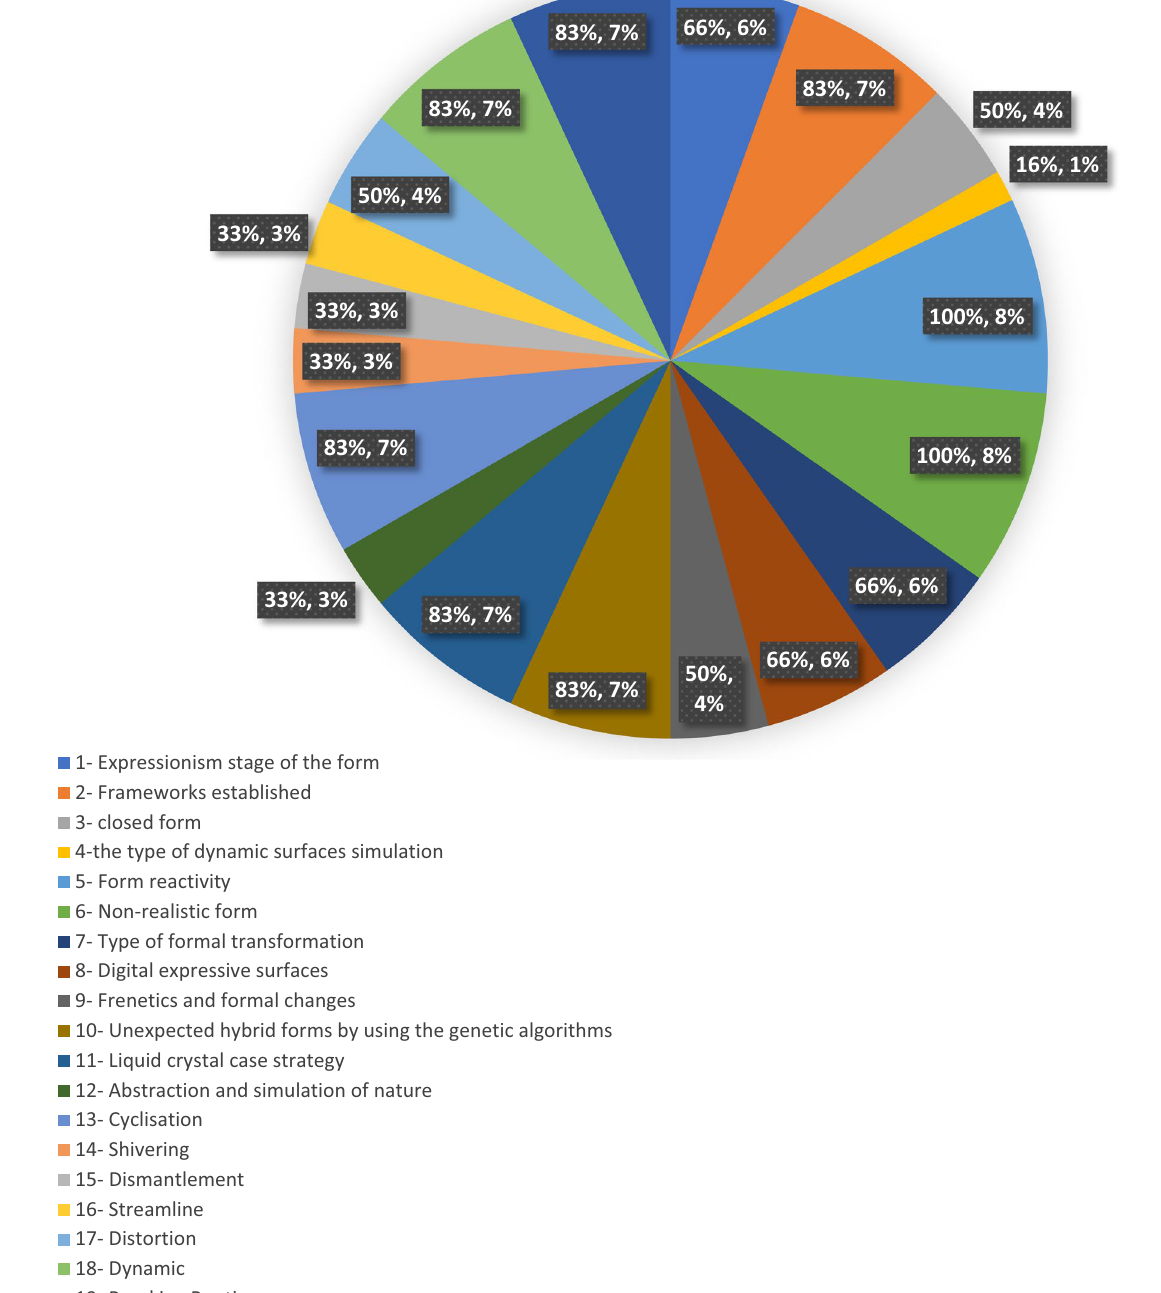
Fig. 12 The percentage (%) of each element of the formal characteristics and non-traditional esthetic values in digital architecture based on the results of the applied practical study and their size in relation to the rest of the elements. Source : the